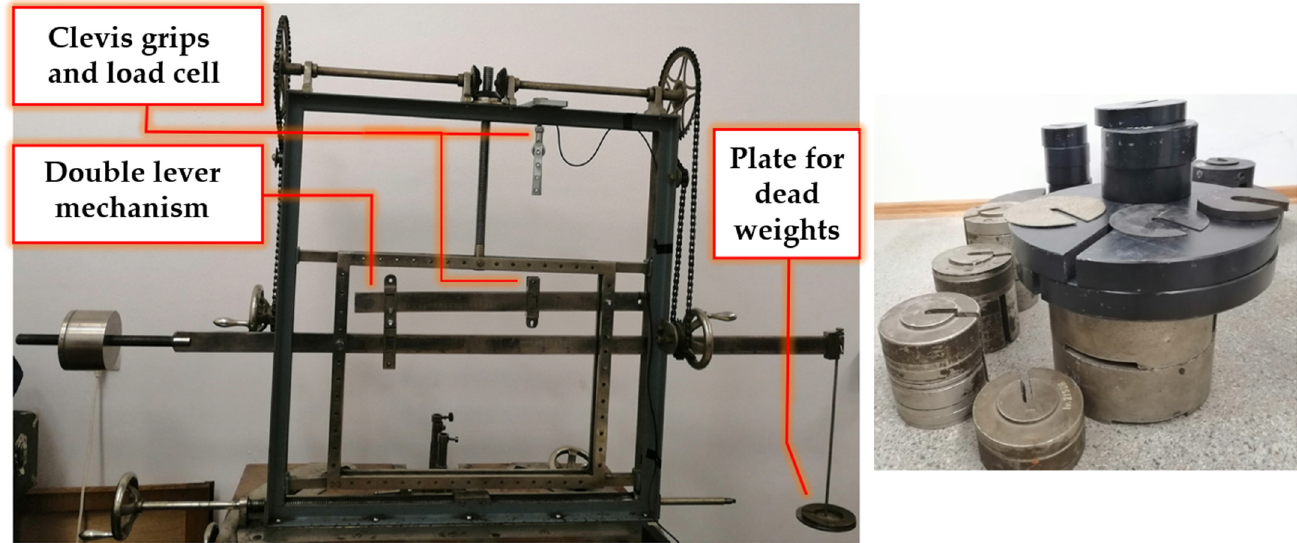
Figure 4. The installation used for creep-recovery testing.